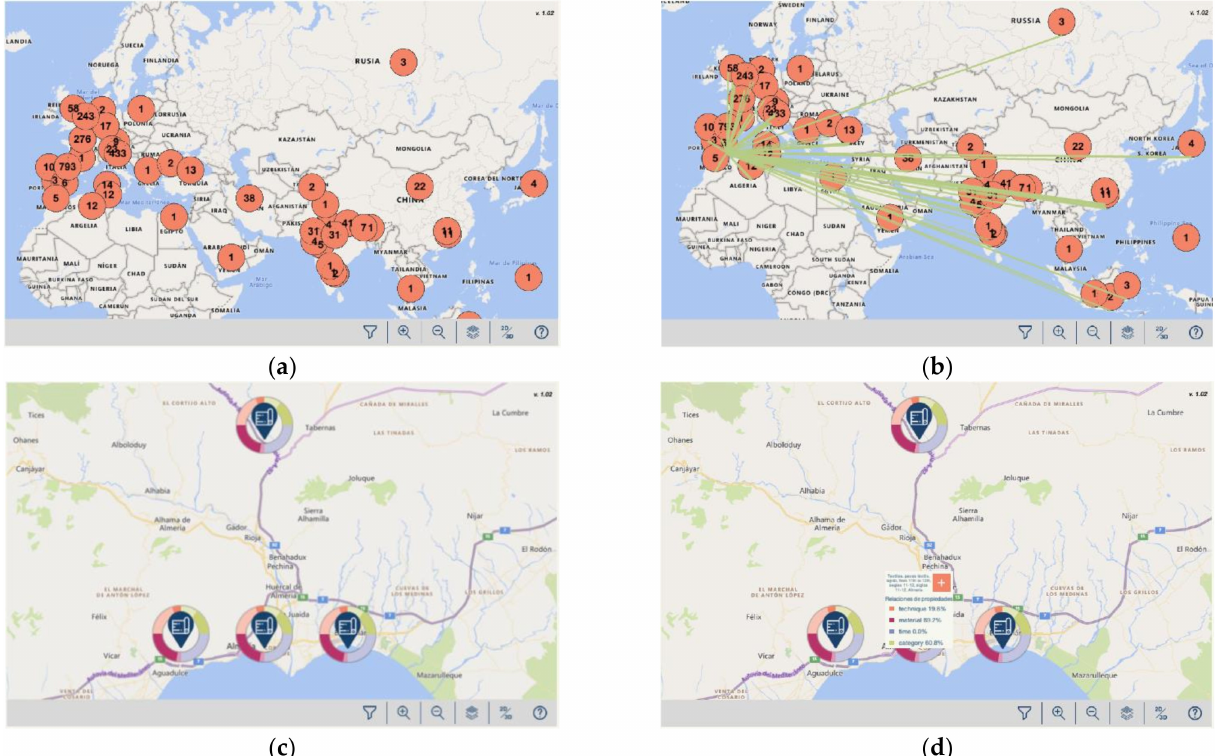
Figure 9. Examples of relationship visualization, where: ( a ) results of a query for objects related to the term “espol í n”; ( b ) visualizing the objects that have the same value for the “category” property than a single object, selected by the user, with the line-based representation; ( c ) visualizing how many objects are related for each object of a query, for the four properties (“technique”, “material”, “time” and “category”), for a small set of objects, using the ring-based representation; ( d ) inspecting the percentages in detail, for one of the objects (the same used in ( b